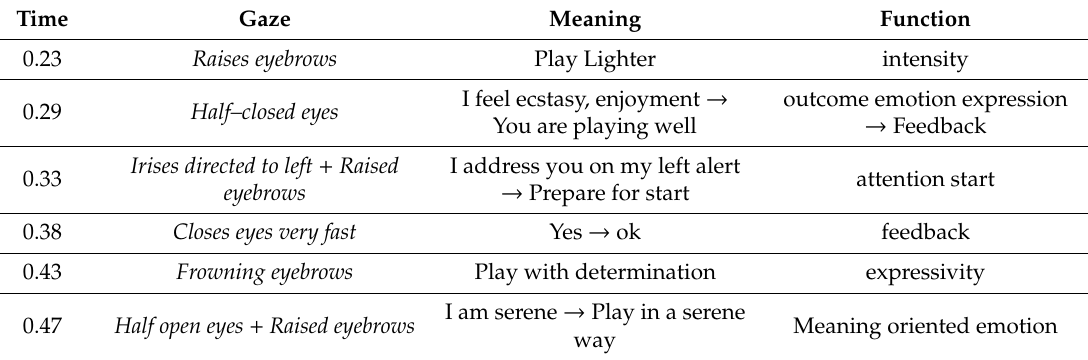
Table 3. A fragment of the annotation scheme of Bernstein’s